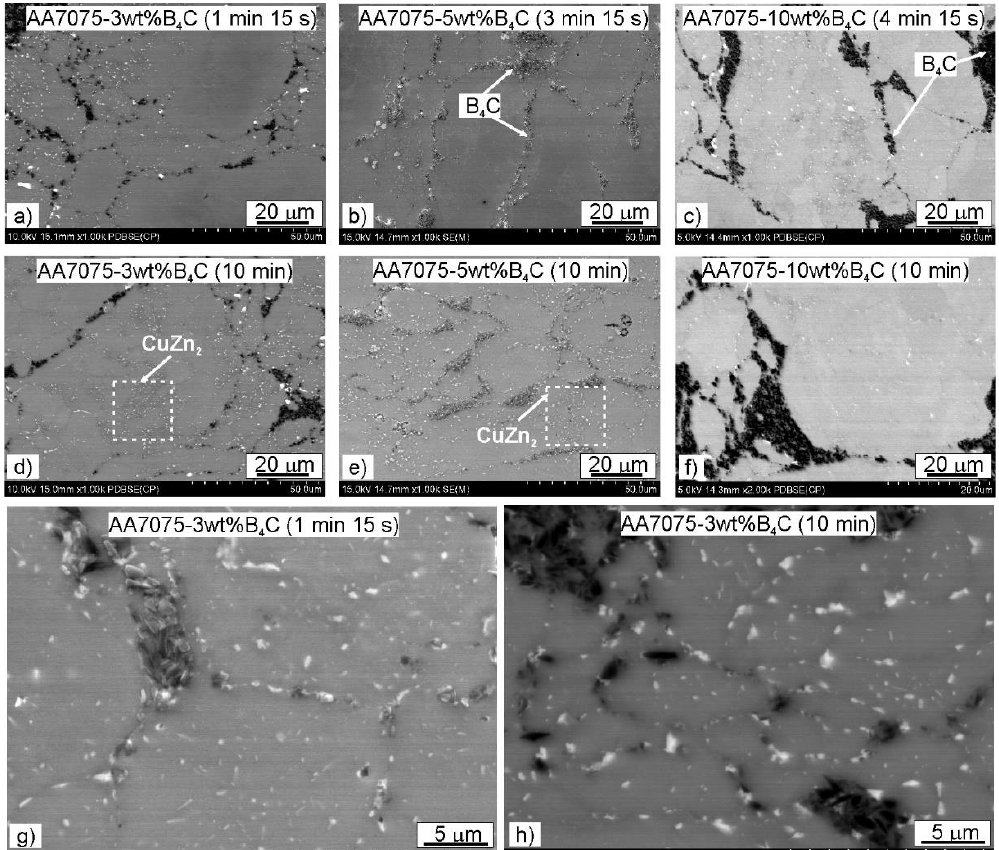
Figure 3. Relative densities of AA7075- x B 4 C ( x = 3, 5, 10 wt%) composites depending on B 4 C con- tent and holding times.